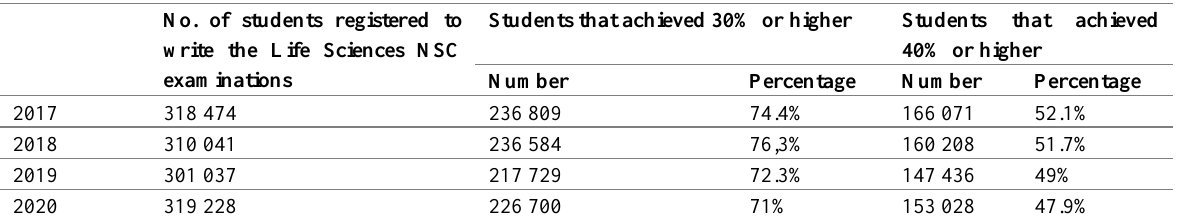
Table 1: Summary of student registered to write the Life Sciences NSC examinations, as well as the levels of